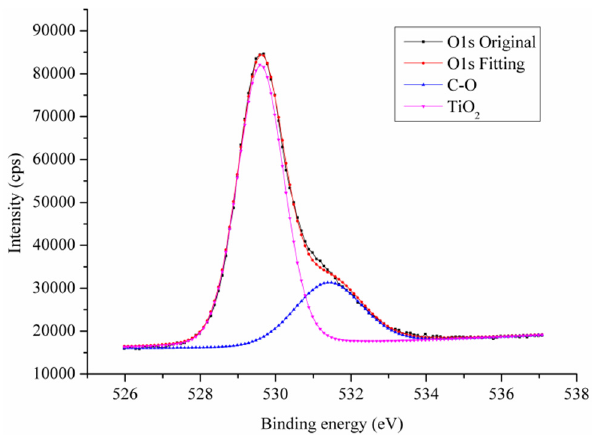
Figure 8. Electronic spectra of O1s characteristic peak on corrosion interface of titanium alloy in air.